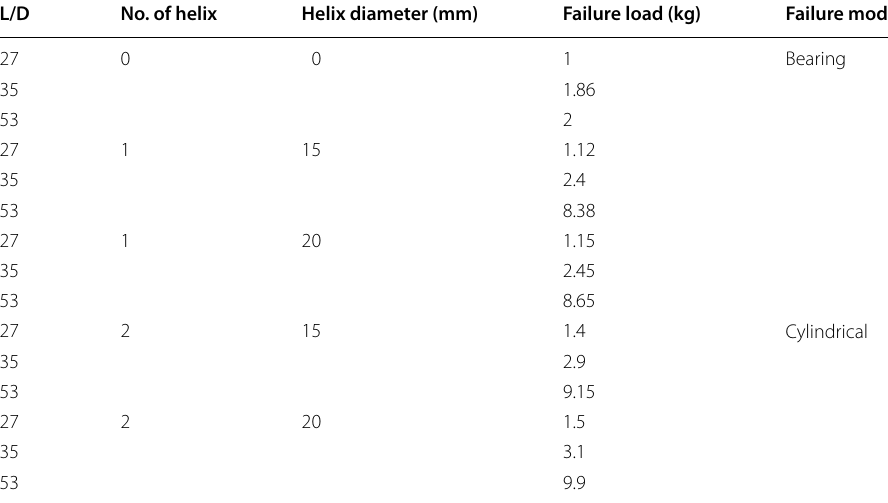
Table 4 Summary of the failure load of helical pile